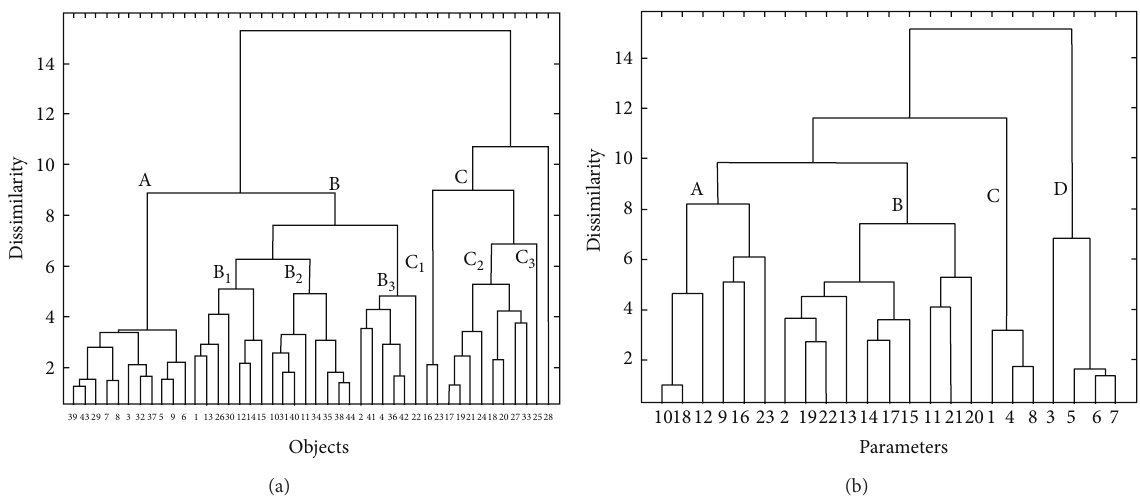
Figure 4: Dendrograms of (a) hard coal samples (objects) in the space of the 23 measured parameters (listed in Table 4) and (b) parameters in the space of 44 objects based on the Ward linkage method using Euclidean distance as the similarity measure.